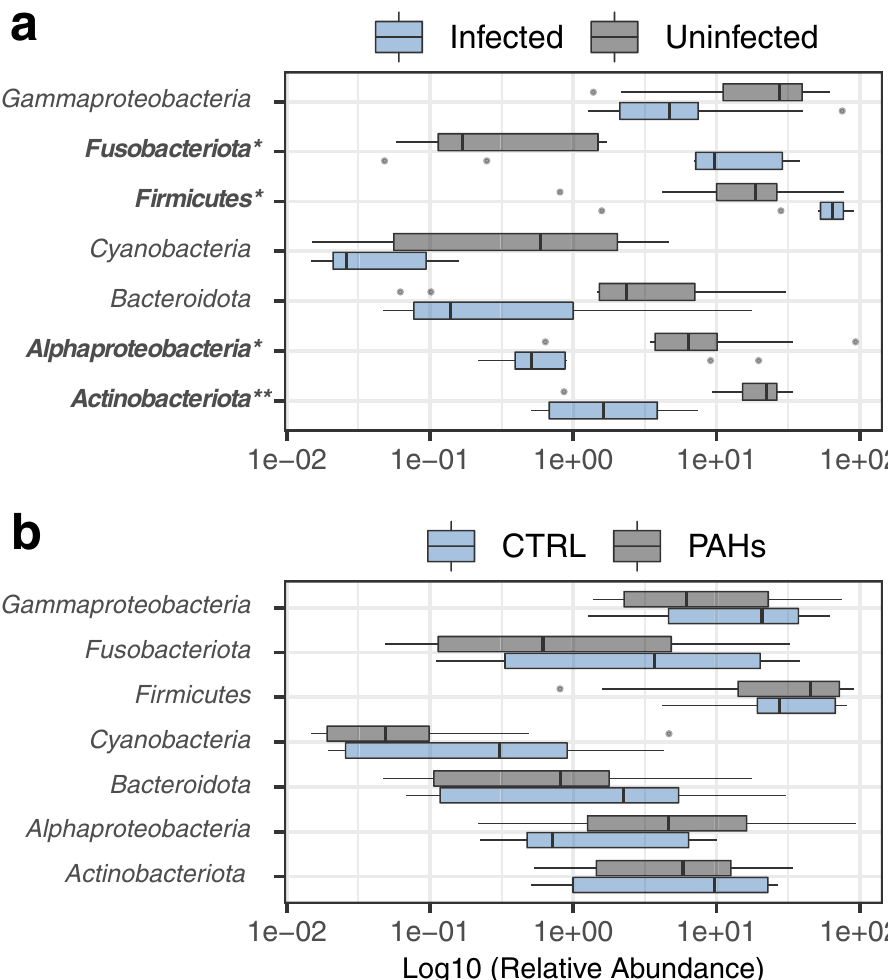
Figure 3. Relative abundance of the main gut bacterial phyla. The relative abundances of the main bacterial phyla were compared between infected and uninfected chub (n = 20 samples) ( a ) and between controls and PAH-exposed chub (n = 20 samples) ( b ). The color refers to the parasitic status (gray: uninfected and blue: infected) or the PAH exposure (gray: PAH-exposed and blue: controls). Mann Whitney Wilcoxon tests were used to compare the groups for each taxon, and significantly differentially abundant taxa were highlighted in bold on the plot. The p values were adjusted with Benjamini–Hochberg corrections to correct for